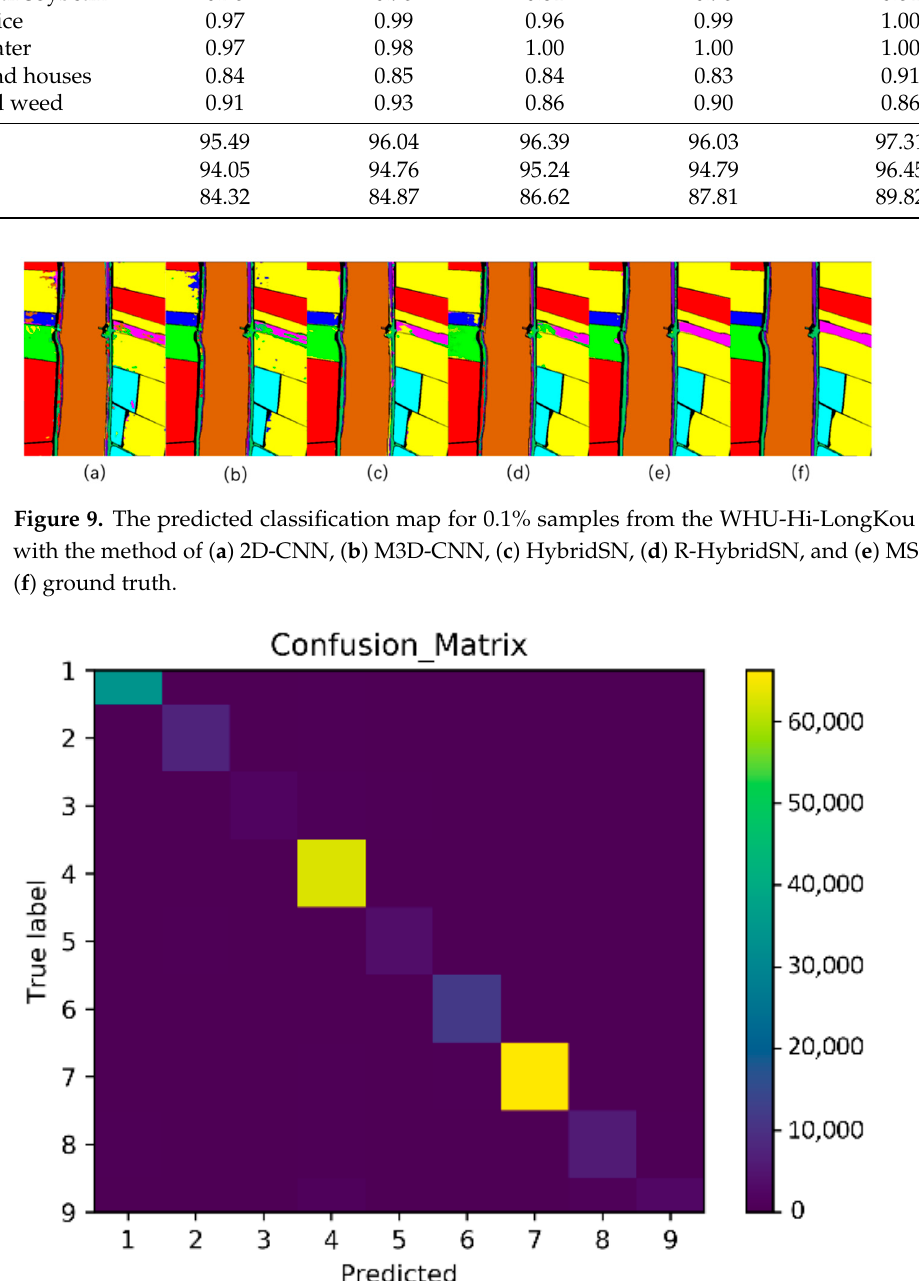
Figure 10. The confusion matrix using the proposed method over 0.1% samples from the WHU-Hi- LongKou